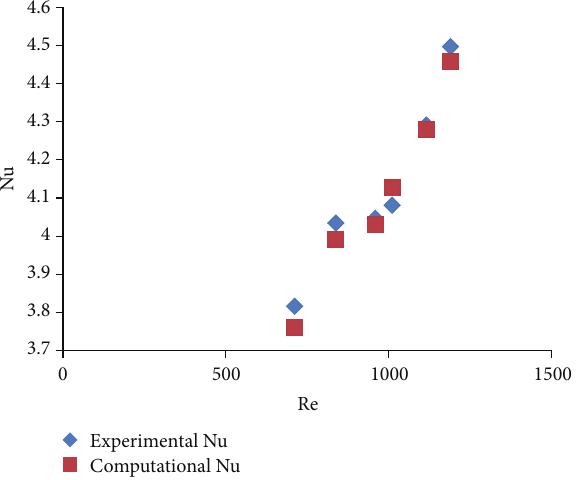
Figure 2: Nusselt number versus Reynolds number for 0.87 mm ID- tube and water.